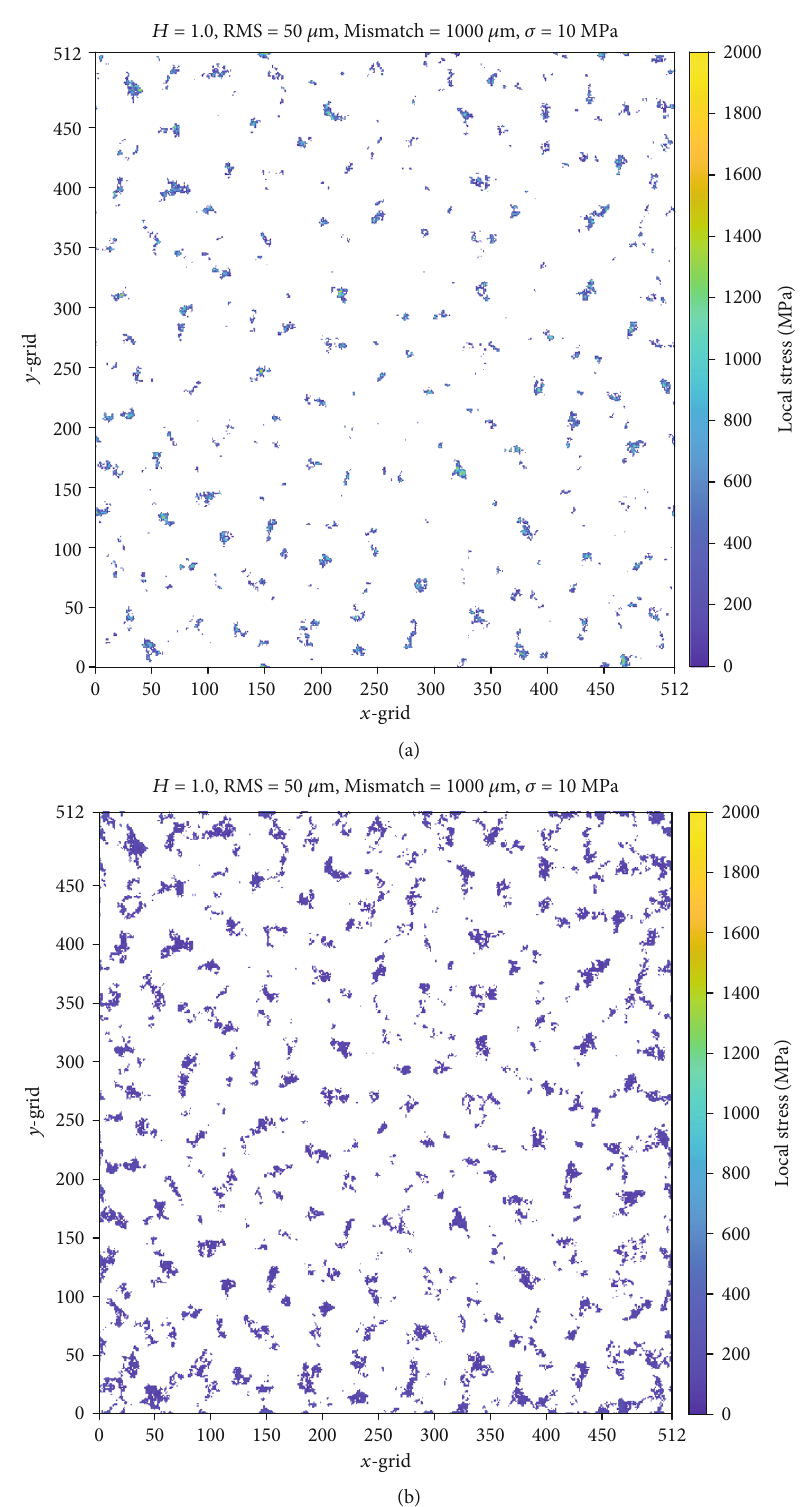
Figure 17: (a) Contact area and local contact stress before creep (the moment after the elastic deformation); (b) contact area and local contact stress after creep (the time duration is 2 τ ). The number of grids in the x and y directions is